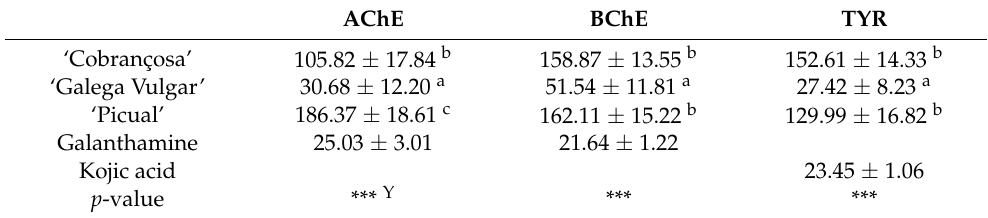
Table 4. Inhibitory activity of olive seeds extracts against acetylcholinesterase (AChE), butyryl- cholinesterase (BChE), and tyrosinase (TYR) (IC 50 , µ g mL − 1